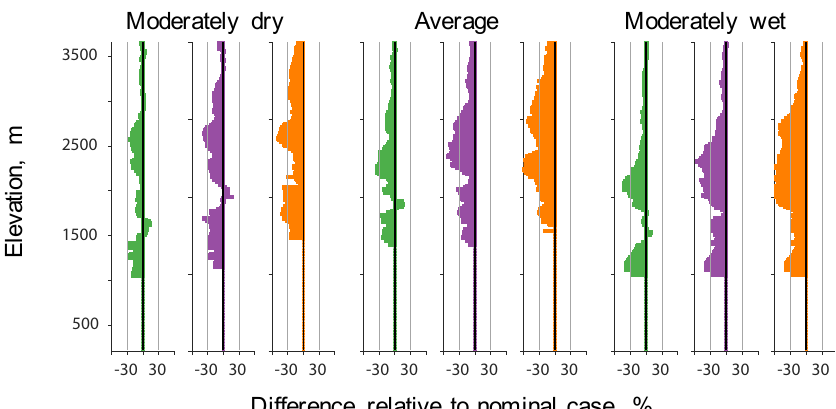
Figure 8. Top row of panels: the elevation distribution ( y axes) of the average total depth of annual meltwater ( x axes) simulated for the nominal case (black lines) and select perturbed temperature scenarios (colored lines). Second row of panels: the fraction of annual meltwater produced at snowmelt rates ≥ 15mmday − 1 . The colored circles indicate elevations at which simulated melt occurs equally at rates ≥ 15mmday − 1 and <15mmday − 1 . The lower panels of colored graphs show the differences from the nominal case, reported in percent of annual meltwater, produced at snowmelt rates ≥ 15mmday − 1 for the three select scenarios. Results are shown for the moderately dry (2009; left column of plots), near-average (2008; middle column of plots), and moderately wet (2010; right column of plots) snow